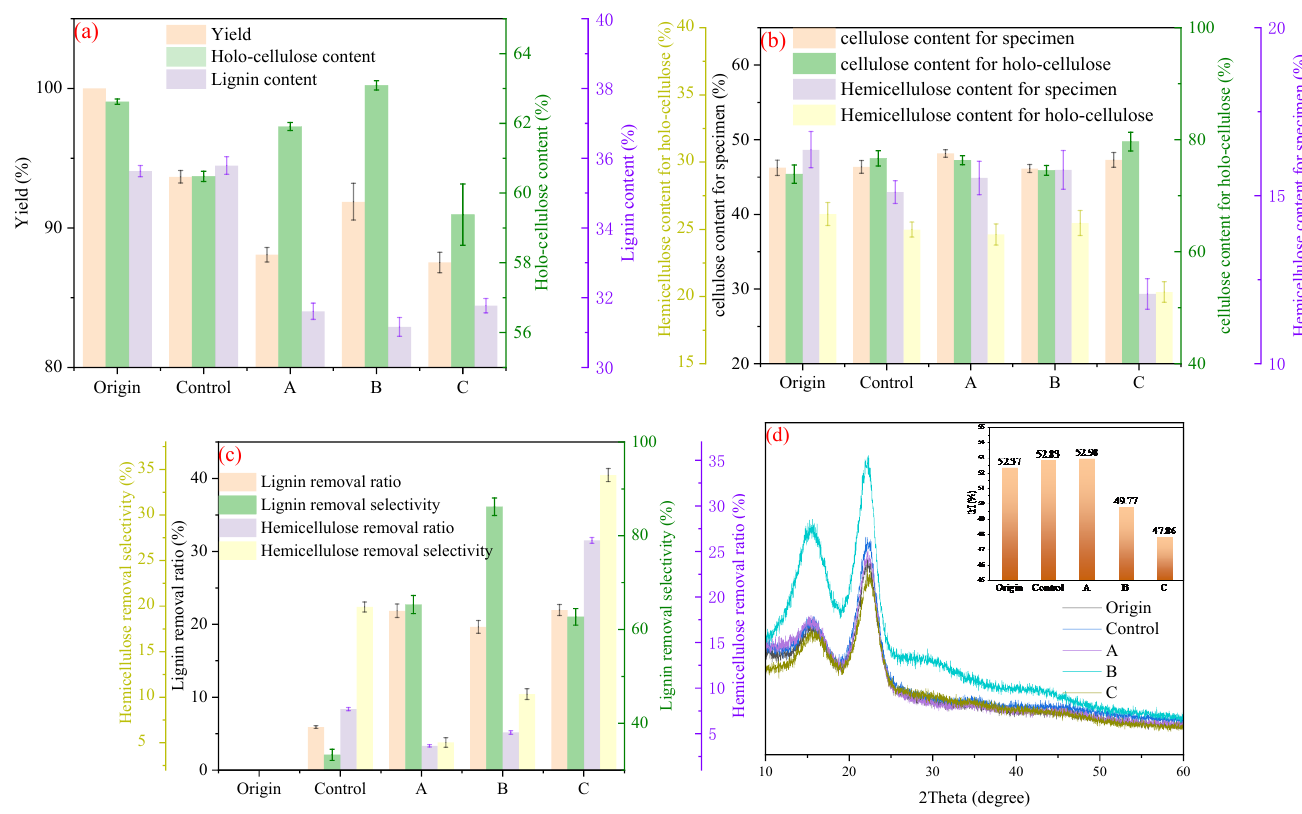
Figure 1. ( a ) Yield, holocellulose, and lignin content; ( b ) cellulose and hemicellulose content; ( c ) removal ratio and removal selectivity of lignin and hemicellulose; ( d ) crystal index of specimens via microbiological pretreatment. A: bamboo chips treated by microorganisms A, B: bamboo chips treated by microorganisms B, C: bamboo chips treated by microbial consortium C.